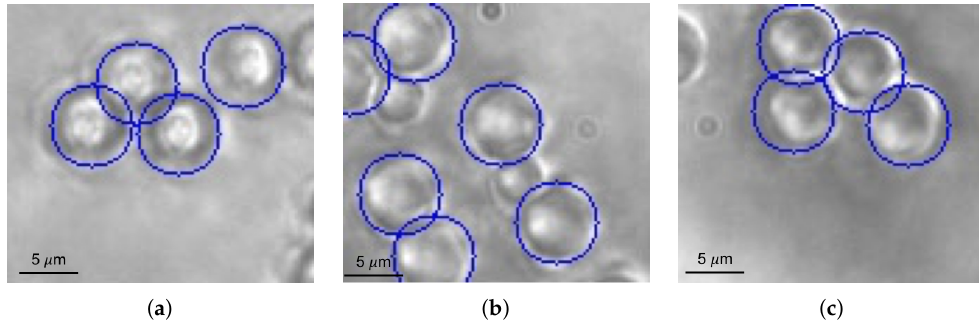
Figure 19. Processed images of densely clustered silica beads in Matrigel: ( a ) single cluster with one bead sightly separated from the rest; ( b ) multiple clusters; ( c ) single cluster with all the beads tightly